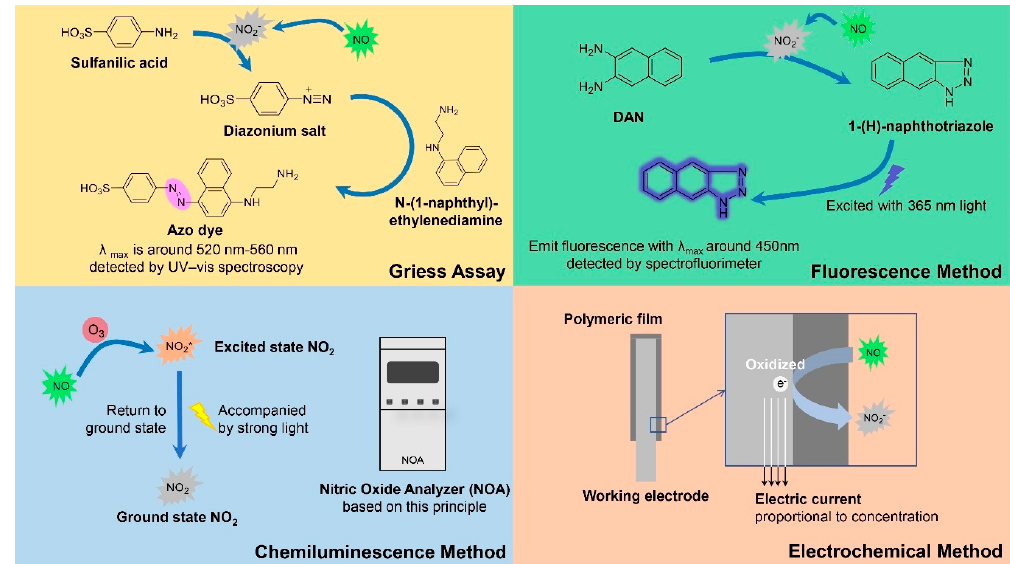
Figure 2. Mechanisms of four methods for detecting NO release.